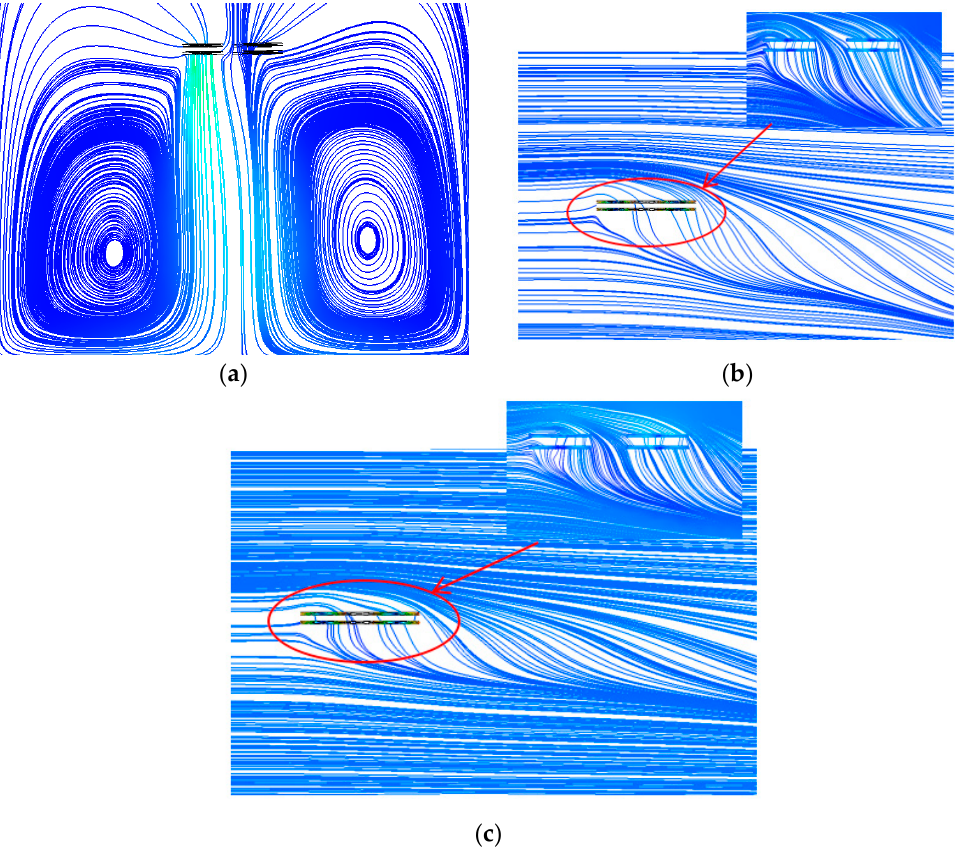
Figure 10. The streamline distribution of the coaxial Tri-rotor (2200 r/min): ( a ) 0 m/s; ( b ) 2.5 m/s; ( c ) 4 m/s.